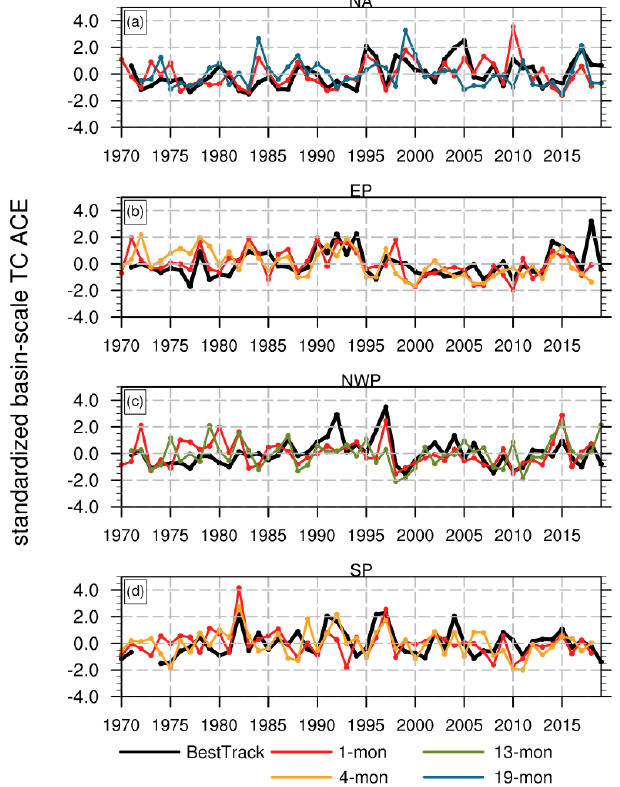
Figure 15. Time series of normalized seasonal-mean (JJASON for the Northern Hemisphere and DJFMAM for the Southern Hemi- sphere) TC accumulated cyclone energy (ACE) for the period of 1970–2018 in the observations (black curves), SMYLE forecasts at 1-month lead (red curves), and the respective SMYLE forecasts at the longest lead that yields a significant correlation (as shown in Ta- ble 3) (colored curves) in the (a) North Atlantic, (b) eastern Pacific, (c) northwestern Pacific, and (d) South Pacific. TC basin bound- aries are shown in Fig. 14. Note that at 19-month lead time (a) , data from SMYLE-NOV are for JJASO (instead of JJASON) given the 24-month simulation length.